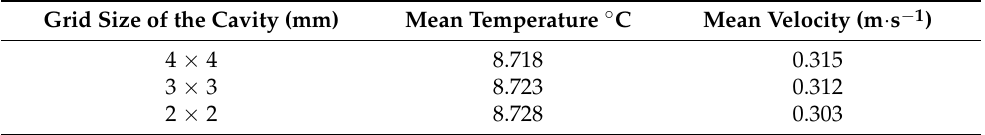
Table 2. Grid test.